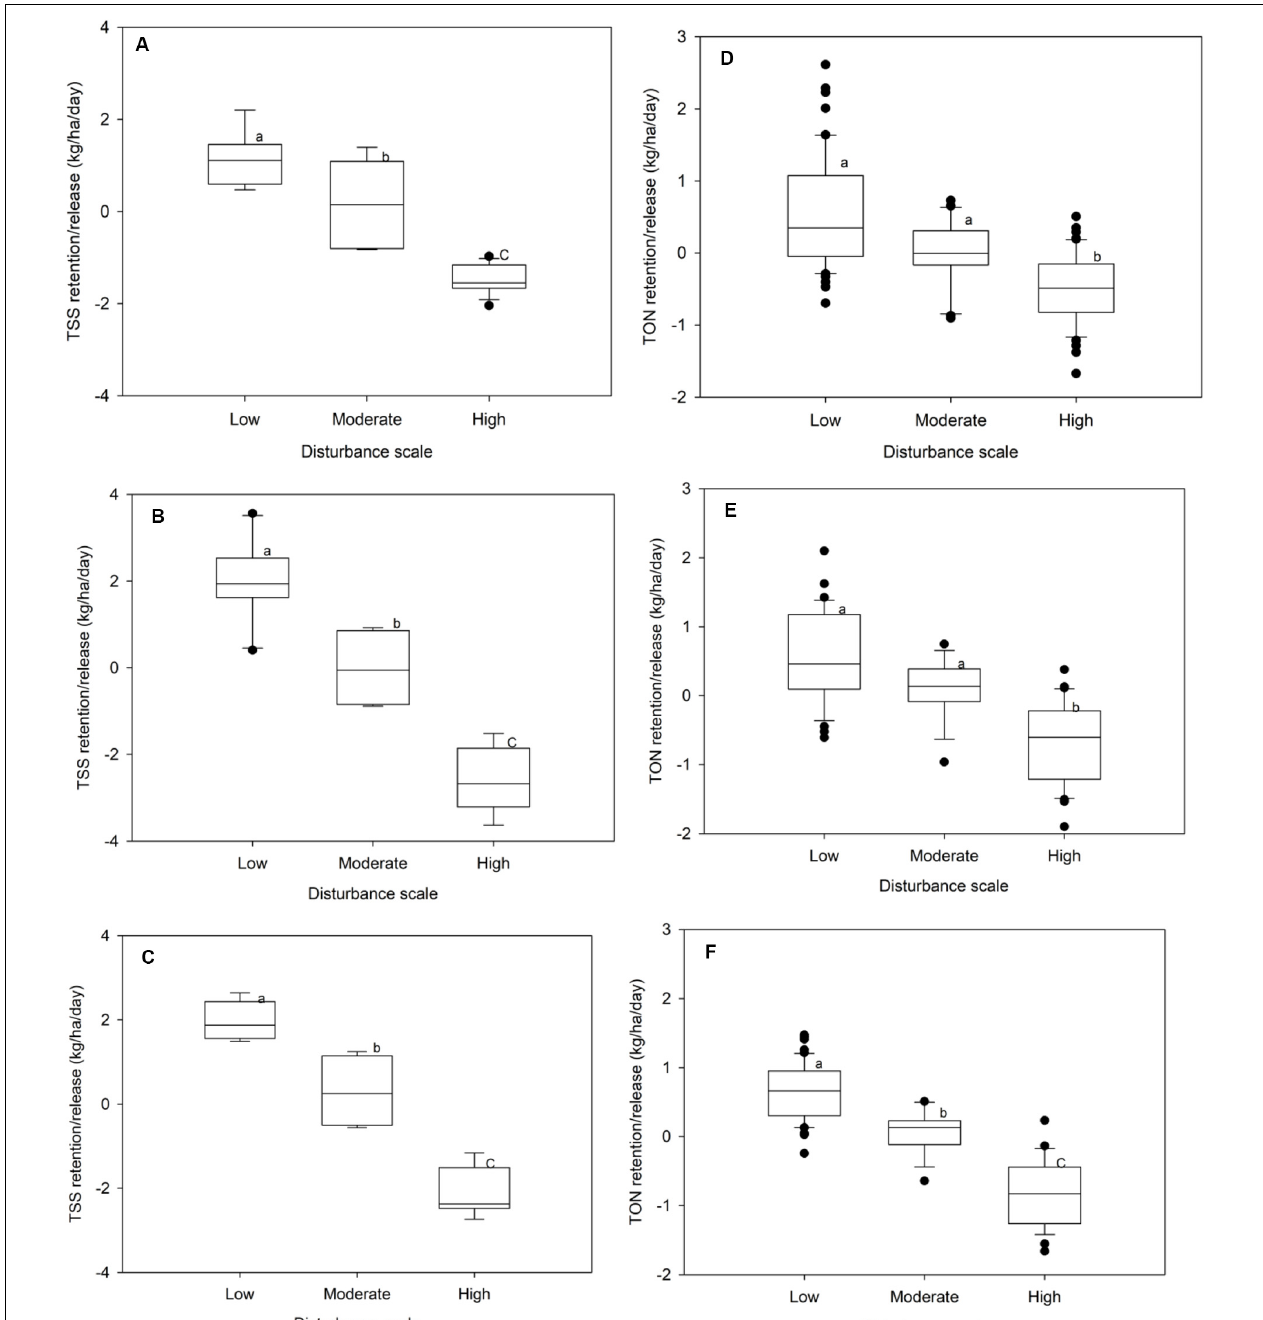
FIGURE 5 | Box- and Whisker plots of the Total Suspended Solids retention log (x + 1) for Kofe (A) , Kito (B) and Awetu-Boye (C) and Total Organic Nitrogen (TON) for Kofe (D) , Kito (E) , and Awetu-Boye (F) in relation to the disturbance classes. The full horizontal line in the box show the median, boxes represent interquartile ranges (25–75% percentiles) and range bars show maximum and minimum values. Statistically significant differences, based on Kruskal-Wallis test ( p < 0.05), are indicated by letters (a, b, and